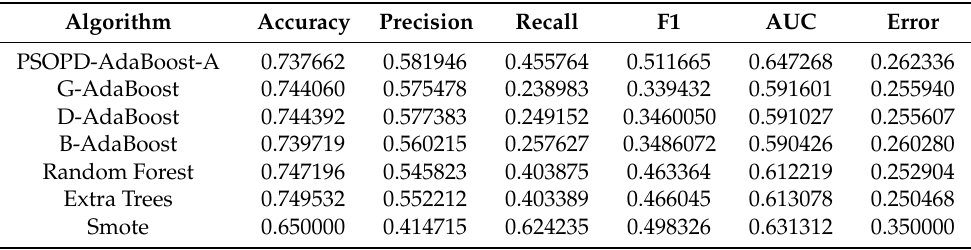
Table 5. Comparison of Classification Results on the PC5 Dataset.